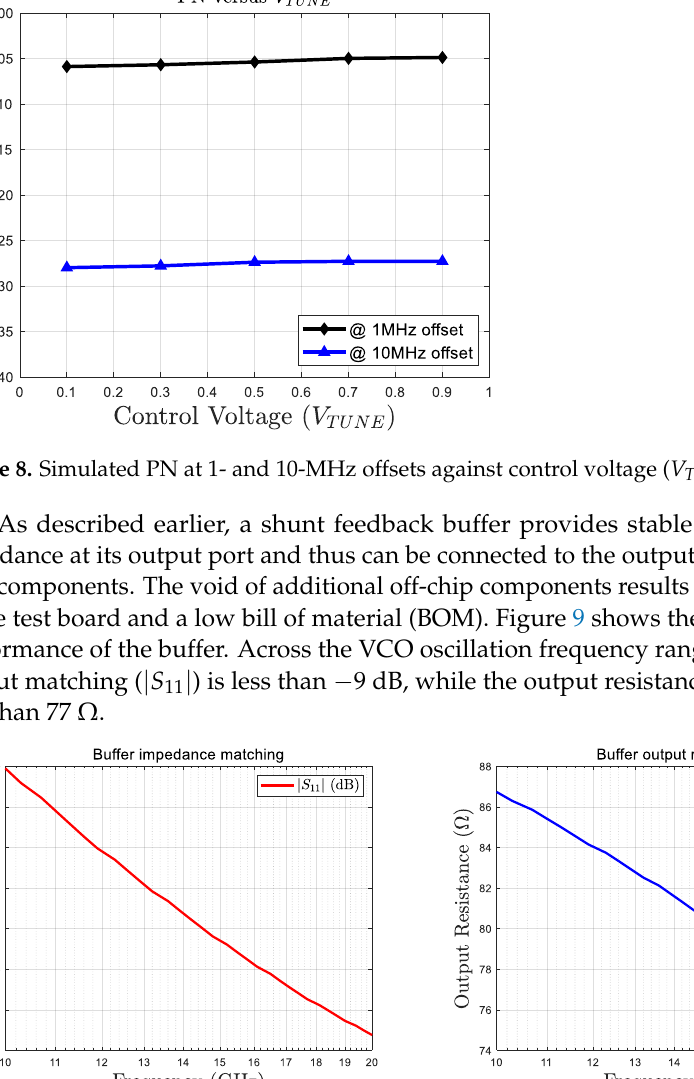
Figure 7. Simulated phase noise (PN) at the lowest ( left ) and highest ( right ) code settings.